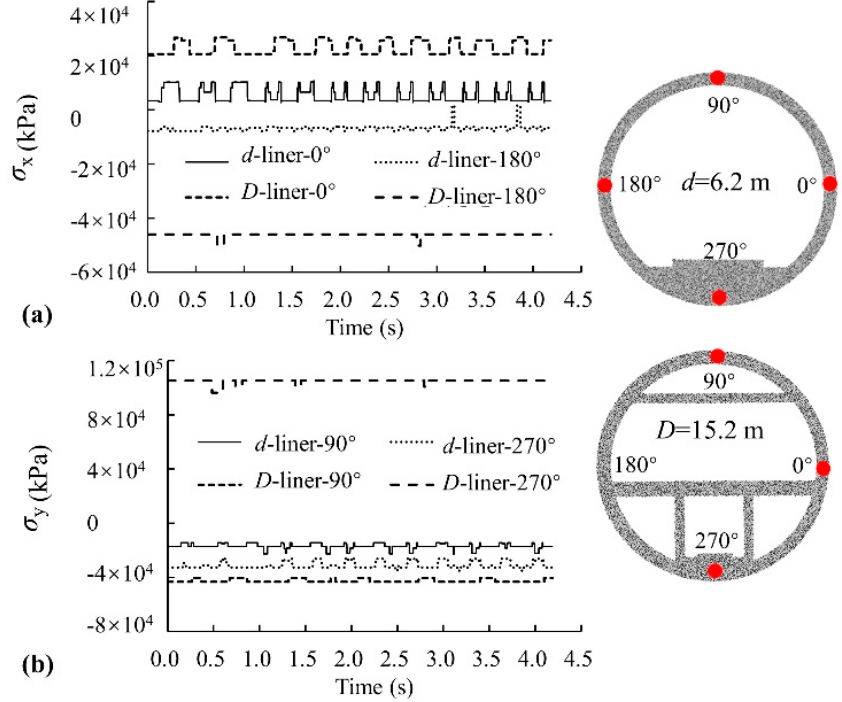
Figure 17. Horizontal and vertical stress of liner in t2 and T2: ( a ) Horizontal stress ( σ x ); ( b ) Vertical stress ( σ y ).